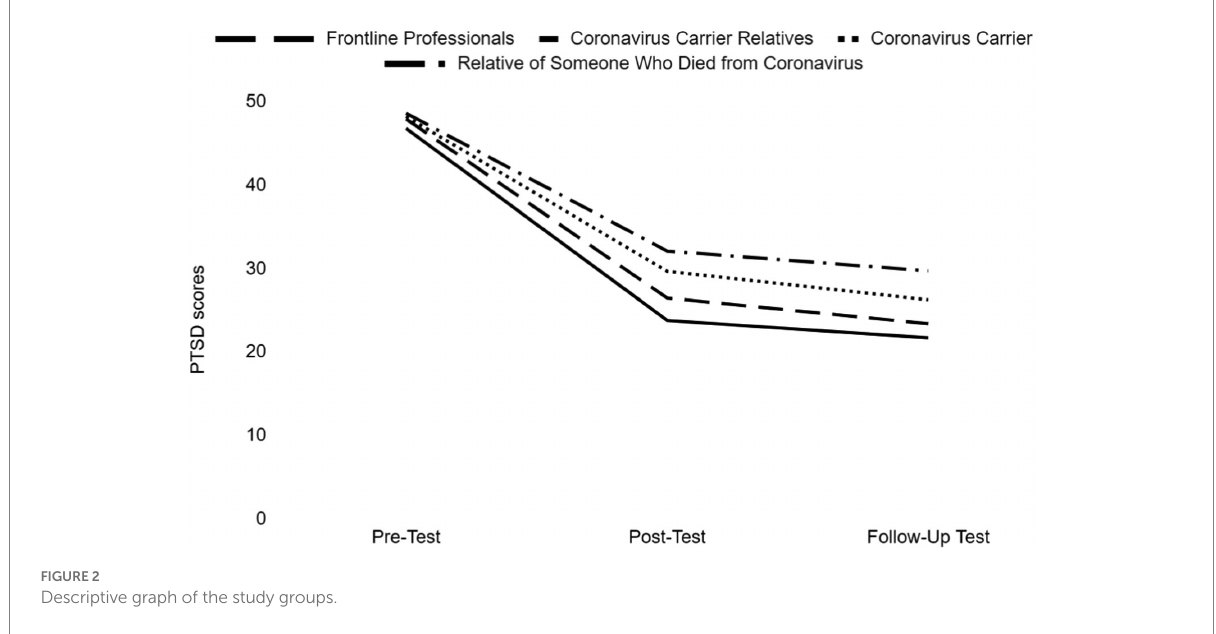
FIGURE 2 Descriptive graph of the study groups.